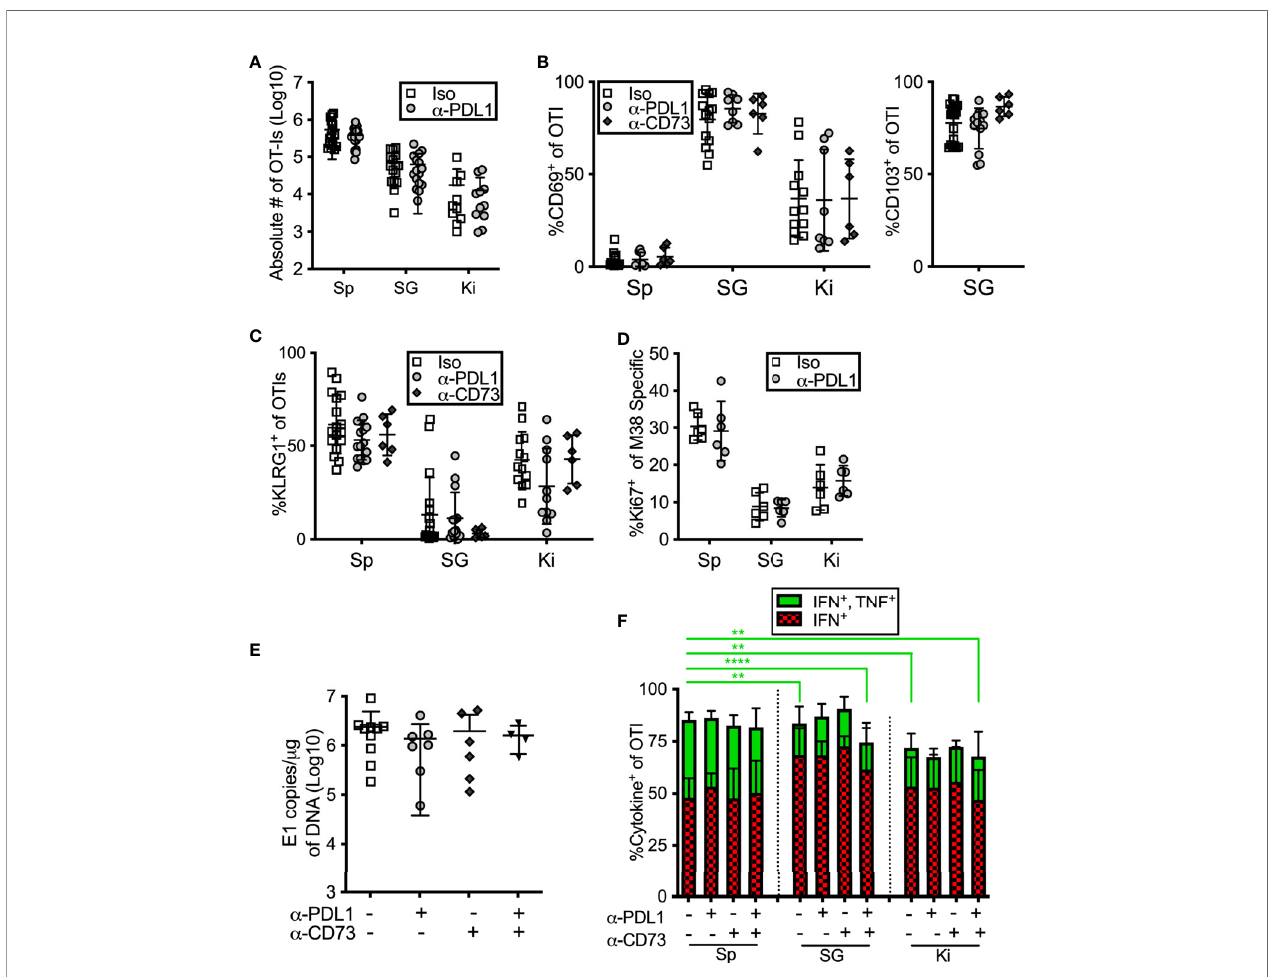
FIGURE 6 | Blocking PD-L1 or CD73 has minimal impact on in vivo maintenance, phenotype or function of T cells. (A – C) Mice were seeded with OT-Is and infected with MCMV-OVA for at least 3 months, and then treated with the indicated blocking antibodies or isotype control (iso) for 2 weeks before sacri fi ce. The data show cells recovered from the indicated organs after antibody treatment including: (A) the absolute numbers of OT-Is, (B) the frequency of CD69 and CD103 expression by OT-Is, and (C) the frequency of KLRG-1 expression by OT-Is, (n=18 from 5 independent experiments). (D) Mice were infected with wild type MCMV and treated with anti-PD-L1 blocking antibody for one week starting on day 7 of infection. Mice were sacri fi ced on day 14 and MCMV speci fi c CD8s were identi fi ed by tetramer staining. The data show the frequency of Ki-67 expression among M38-speci fi c CD8s, (n=6 from 2 independent experiments). (E) Mice were infected with wild type MCMV and treated with the indicated blocking antibodies for two weeks starting on day 7 of infection. Mice were sacri fi ced on day 21 and viral DNA load was determined in the indicated organs by qPCR. Shown are the copies of viral genome per ug of DNA, (n=6 from 2 independent experiments). (F) Mice were seeded with OT-Is and infected with MCMV-OVA for at least 3 months, and then treated with the indicated blocking antibodies for 2 weeks. Following antibody treatment, mice were injected with SIINFEKL peptide (200 m g i.v and 50 m g directly into the salivary gland). Six hours after peptide injection, mice were sacri fi ced and organs were collected and processed in media containing brefeldin A. Shown is the frequency of IFN- g and TNF- a producing OT-Is that were recovered. For comparison of cells from different organs of the same mice, paired two-tailed t-tests were used. For comparison of cells in the same organ but from different mice with different treatments (e.g. blockade or isotype control antibody) populations were analyzed by unpaired two-tailed t-tests. Data are from n=6 mice from 2 independent experiments. *p ≤ 0.05, **p ≤ 0.01, ***p ≤ 0.001, ****p ≤